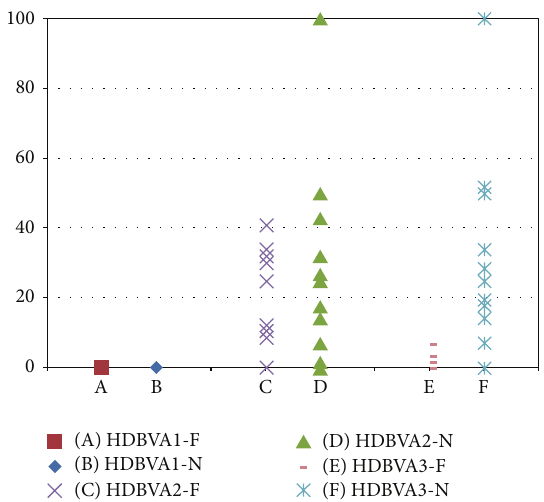
Figure 14: Out-Range slider displacement percentages of case Figure 10(a).